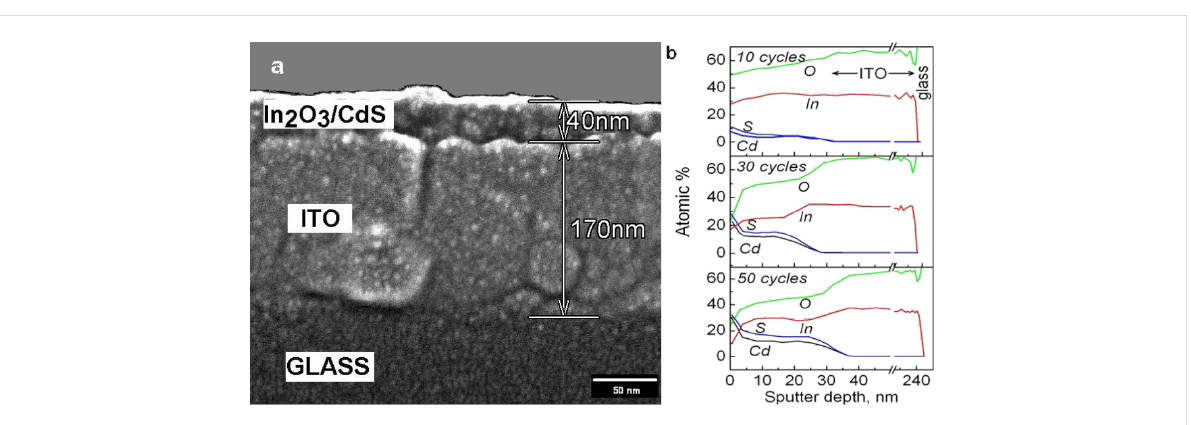
Figure 2: Cross-sectional SEM image of the In 2 O 3 (400) film after 30 SILAR CdS deposition cycles (a) and AES profiles for In 2 O 3 (400)/CdS struc- tures with different numbers of SILAR cycles (b). Scaling from sputter time to depth in AES profiles was done on the basis of cross-sectional SEM data.